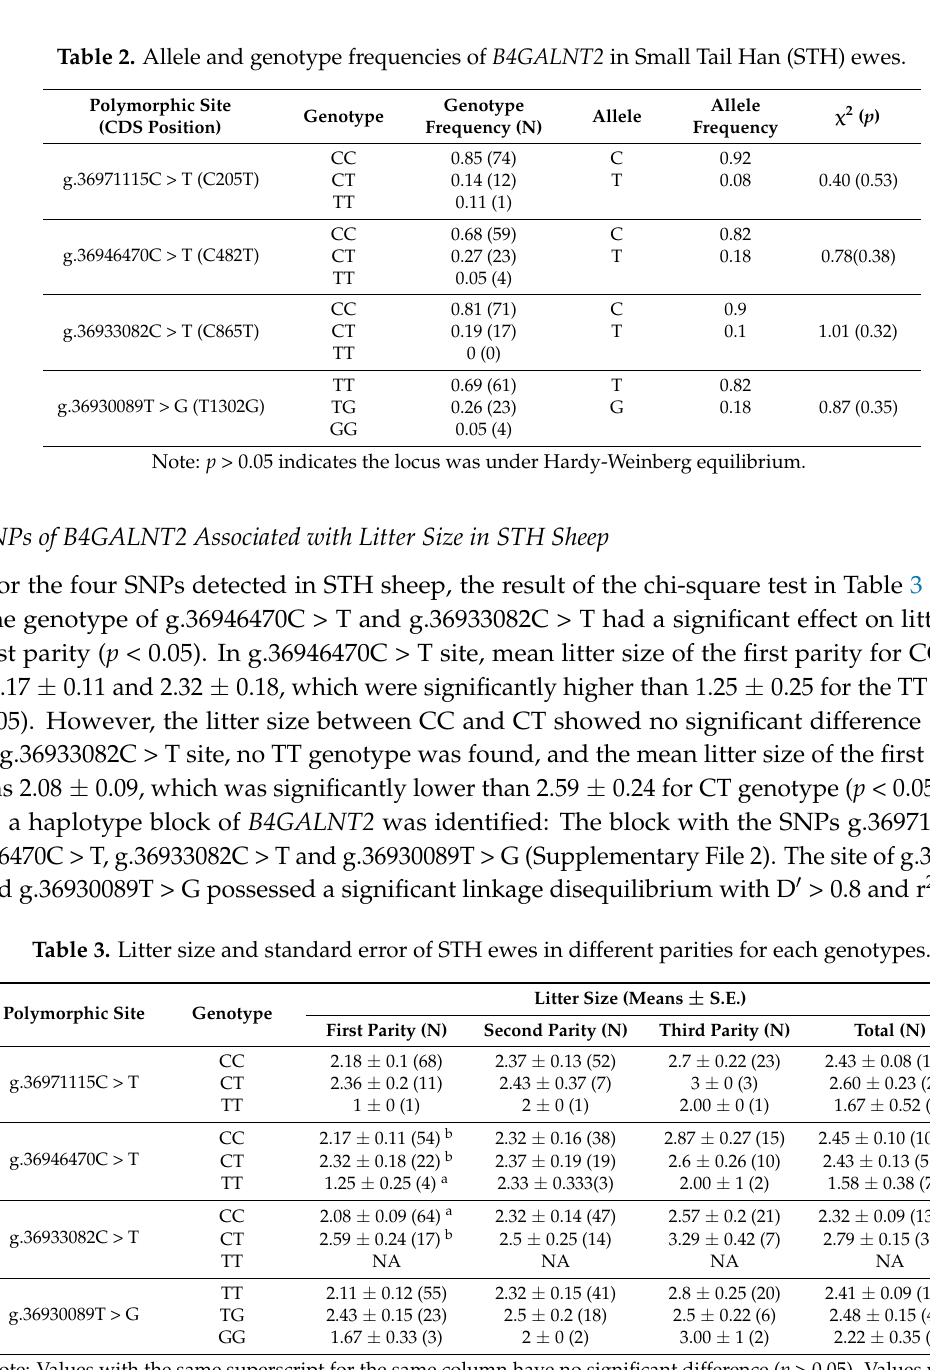
Litter Size (Means ±